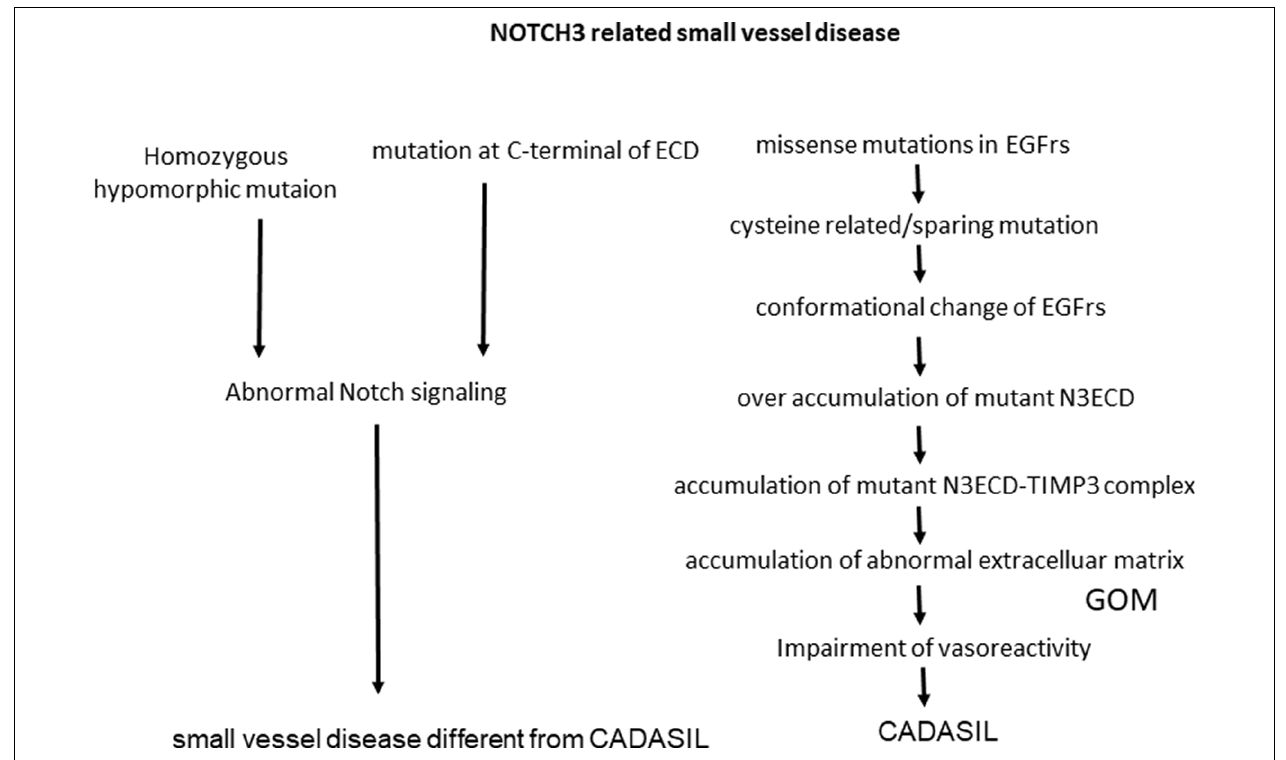
FIGURE 1 | NOTCH3 is related to small vessel disease. ECD, extracellular domain; N3ECD, Notch3 extracellular domain; EGFrs, Epidermal Growth Factor repeats; GOM, granular osmiophilic material; TIMP3, tissue inhibitor of metalloproteinases